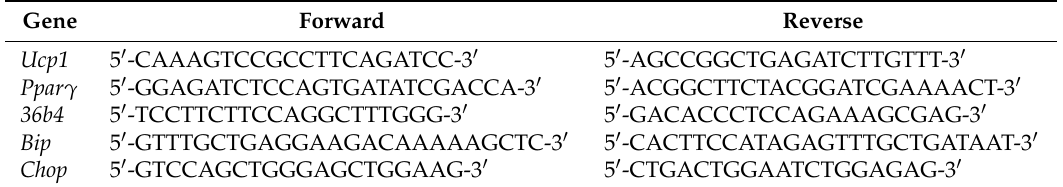
Table 1. Primers used for RNA